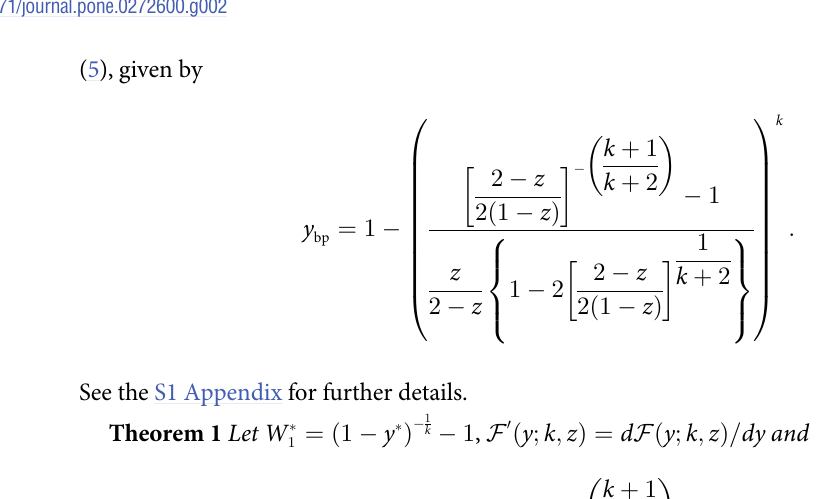
Fig 2. Numerical solutions of equilibrium y � as a function of R 0 with different k values, but fixed z = 0.96.